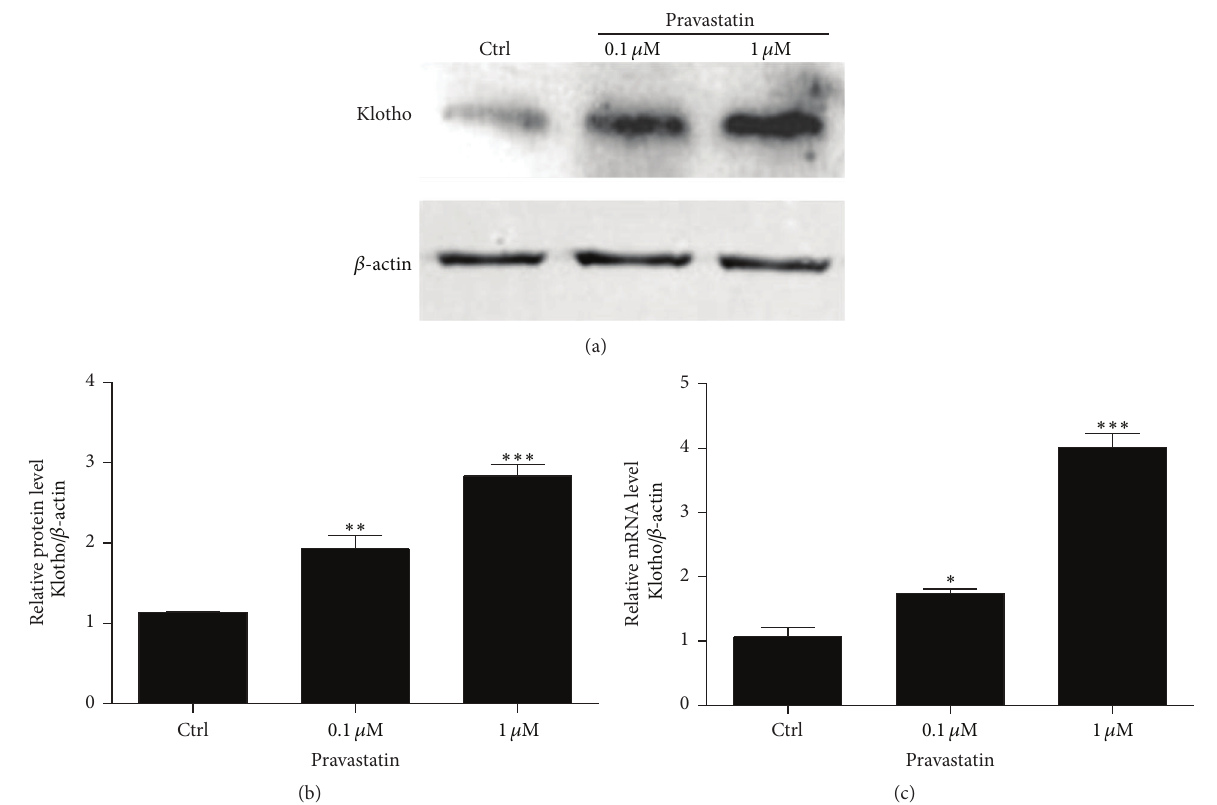
Figure 1: Pravastatin induced klotho expression in HUVECs. (a) Western blotting analysis of klotho in HUVECs. (b) Densitometric analysis of klotho Western blots. (c) Using qRT-PCR, pravastatin effect on klotho mRNA expression in HUVECs was determined. The values represent the means ± SDs ( 𝑛 = 4 in each group). ∗ 𝑝 < 0.05 versus Ctrl group. ∗∗∗ 𝑝 < 0.001 versus Ctrl group.